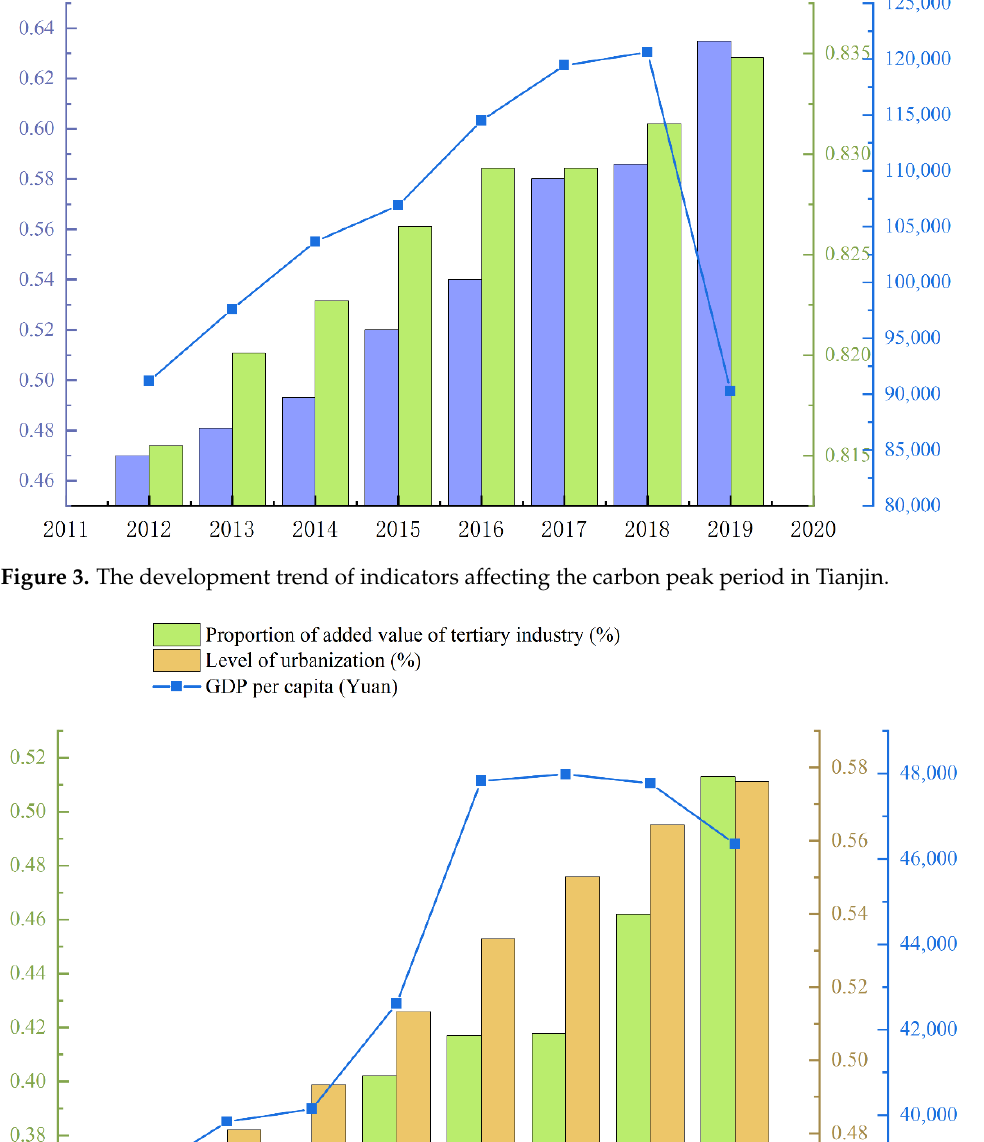
Figure 4. Indicators affecting the carbon peak period in Hebei Province.